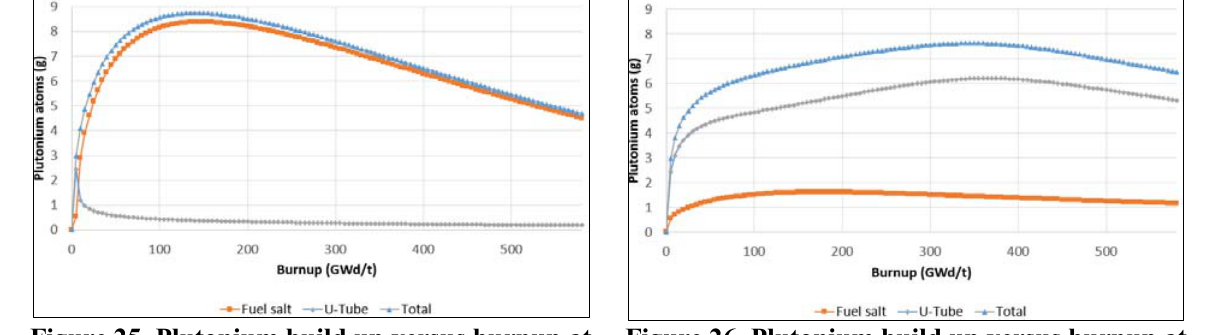
Figure 25. Plutonium build up versus burnup at =540cm); Maximum-diffusion case ϒ=69% (h c